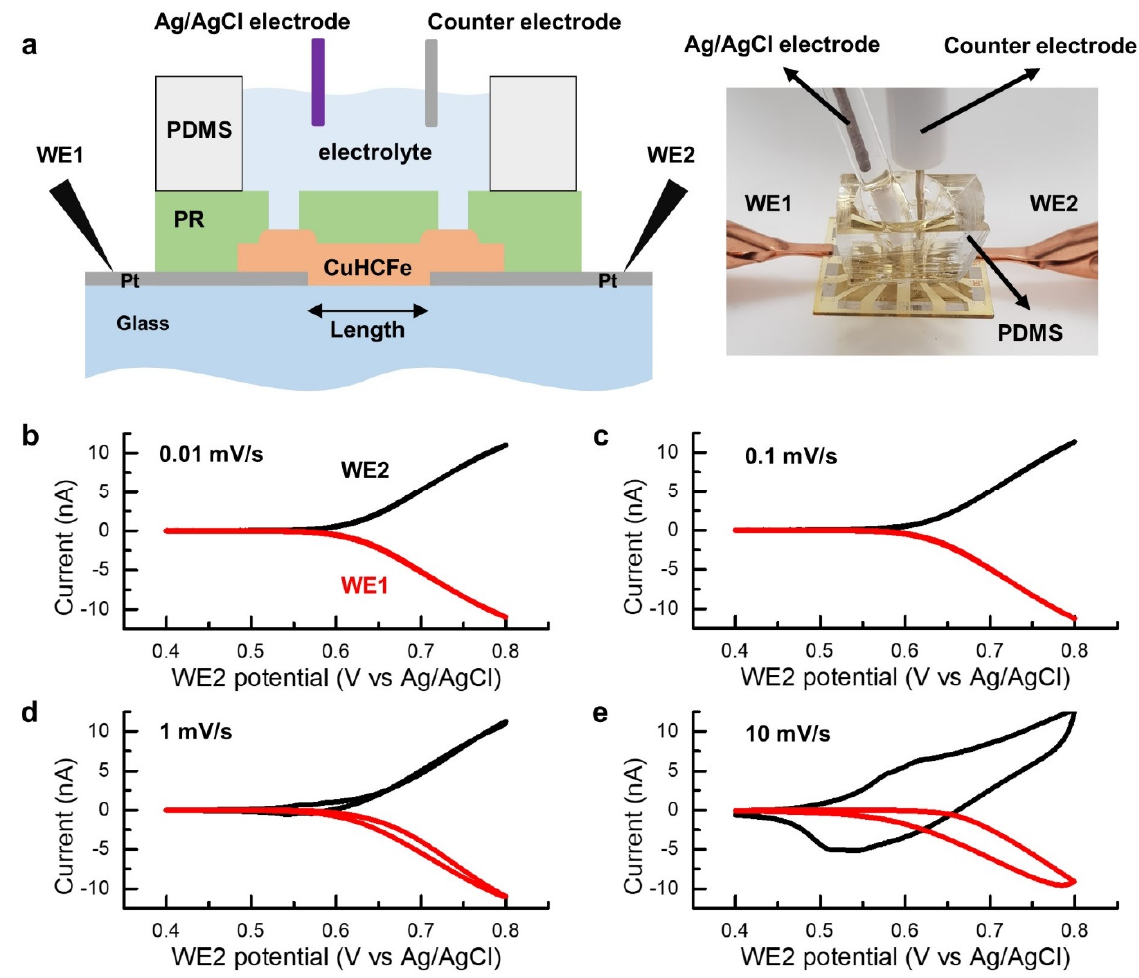
Figure 6. ( a ) Electrochemical system with the microdevice. 0.4 V (vs. Ag/AgCl) was applied to WE1 and sweeping potential between 0.4 and 0.8 V (vs. Ag/AgCl) was applied to WE2. The electrical current of WE1 and WE2 at different scan rate of WE2 (( b ): 0.01 mV/s, ( c ): 0.1 mV/s, ( d ): 1 mV/s, and ( e ): 10 mV/s).